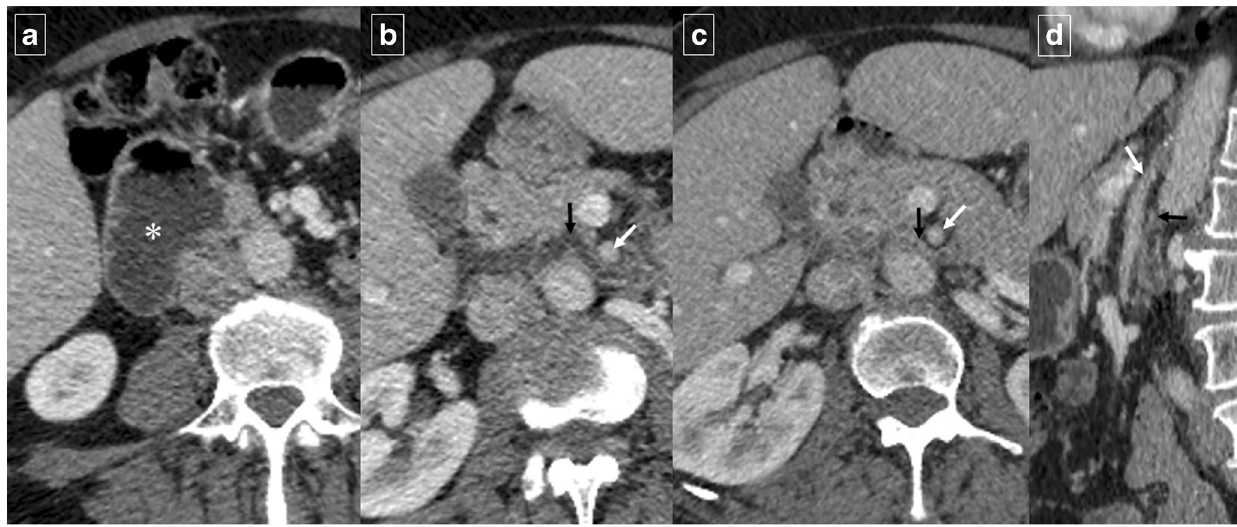
Fig. 24 A 31-year-old woman with suspected superior mesenteric artery (SMA) syndrome. Axial contrast-enhanced CTimages (a, b, and c) show a dilated proximal duodenum (*) with abrupt narrowing of the third portion (black arrows) corresponding with the course of SMA (white